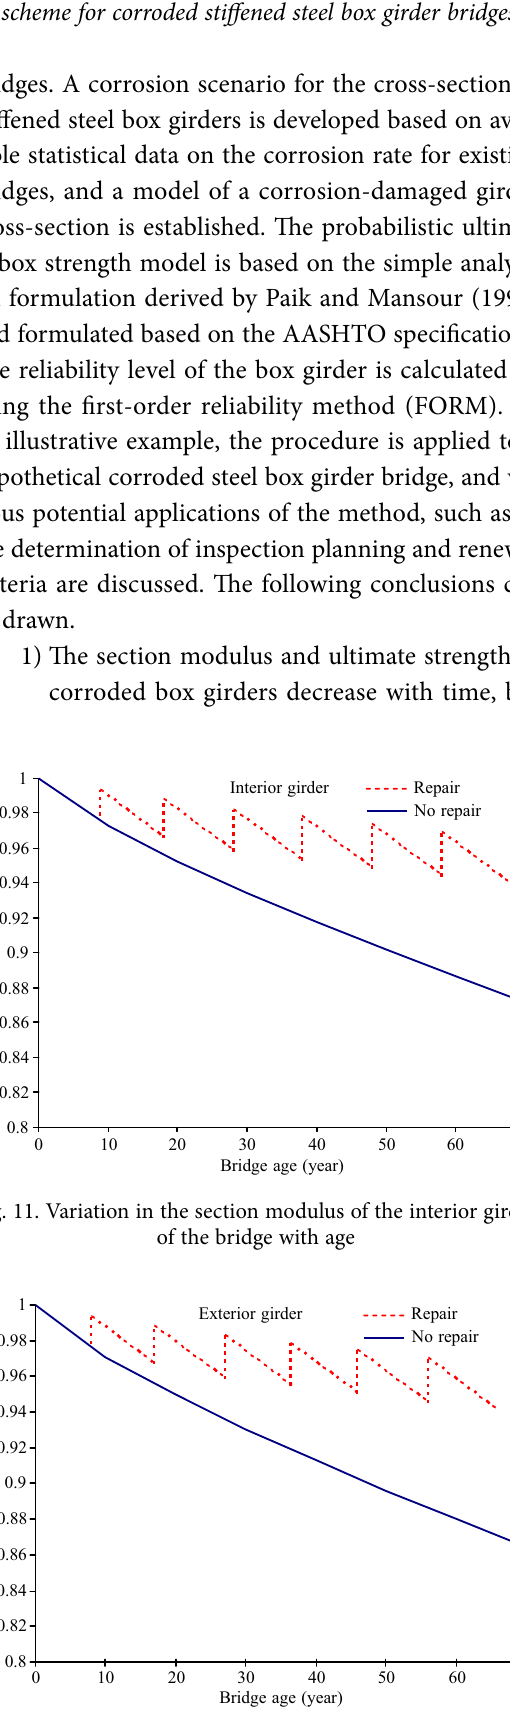
Fig. 12. Variation in the section modulus of the exterior girder of the bridge with